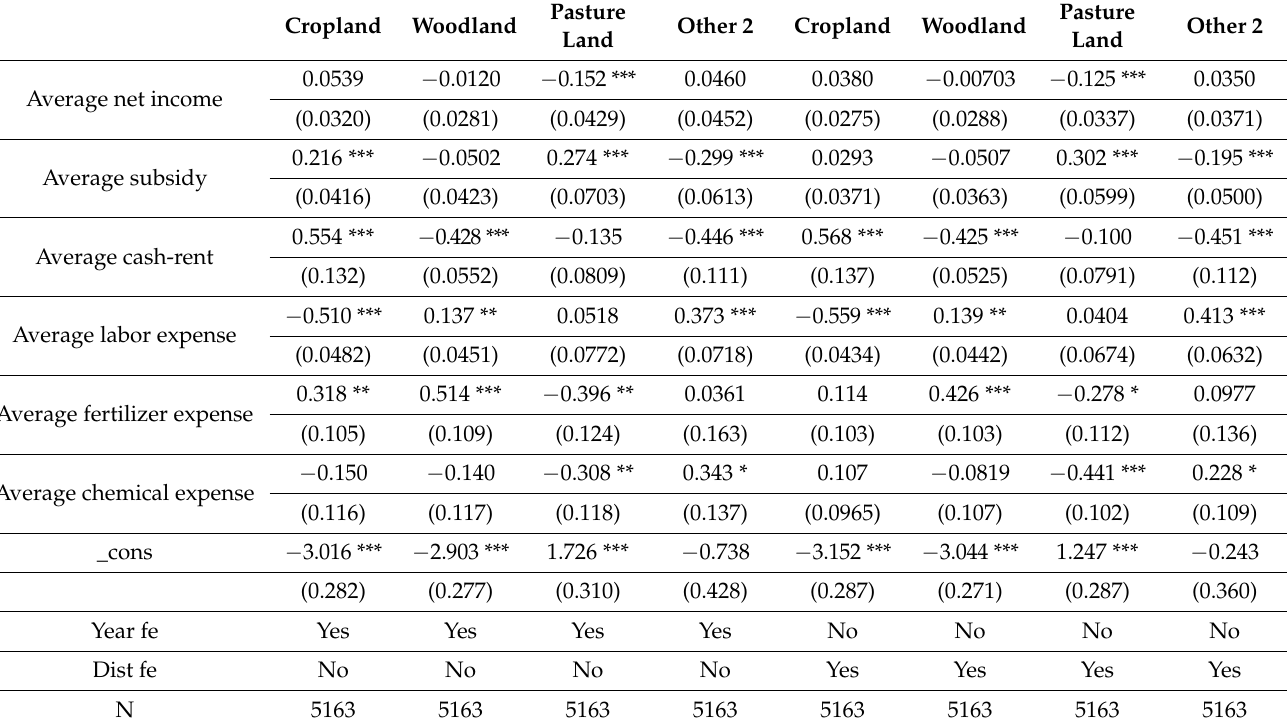
Table 3. Estimated Coefficients on Land-Use of Cropland, Woodland and Pastureland in Multinomial- Fractional-Logit Model.